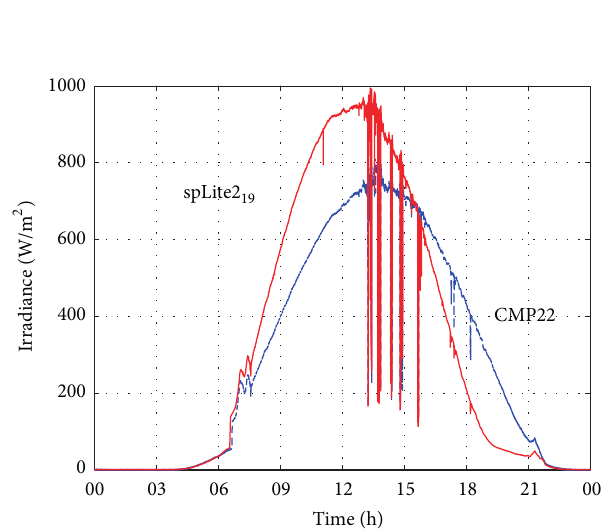
Figure 10: Solar radiation on the plane of PV modules measured by sensor S19 (red line) and on the horizontal plane measured by pyranometer CMP22 (blue dashed line) on July 22nd,